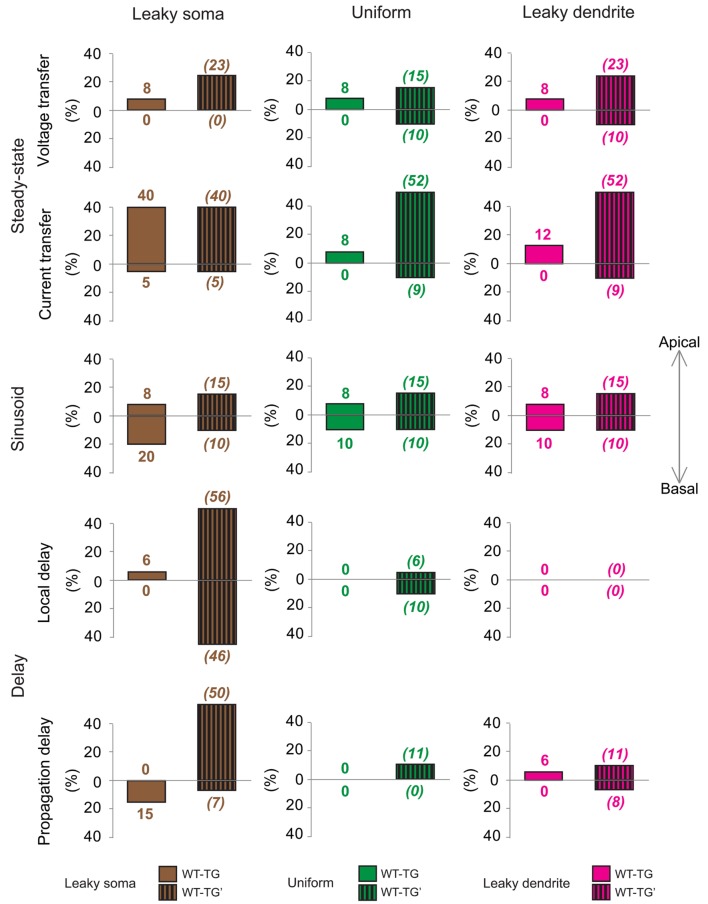
Effects of morphological degeneration on dendritic signaling is compensated by amyloid-related changes of the plasma membrane in TG neurons. Percentage differences between TG and WT (solid bars) as well as between TG’ and WT (striped bars) neurons are drawn as percentages of the number of ranges in comparison graphs where statistically significant difference was found in TG-WT and TG’-WT comparisons relative to the total number of ranges where statistical tests were performed. Therefore, 100% difference would mean entirely (significant difference in all ranges of comparison graphs) different dendritic impulse propagation in the compared neurons, while 0% difference means no difference (compared neurons do not differ significantly in any range of comparison graphs). Note that bars with striped lines tend to be bigger than filled bars depicting smaller differences in dendritic signaling between WT and TG neurons with altered membrane than between WT and TG’ neurons with no alteration in membrane properties (no compensation for dendritic atrophy). Brown, green, and magenta colors refer to leaky soma, uniform and leaky dendrites membrane models. Summarized data are based on Supplementary Figures S1–S5.